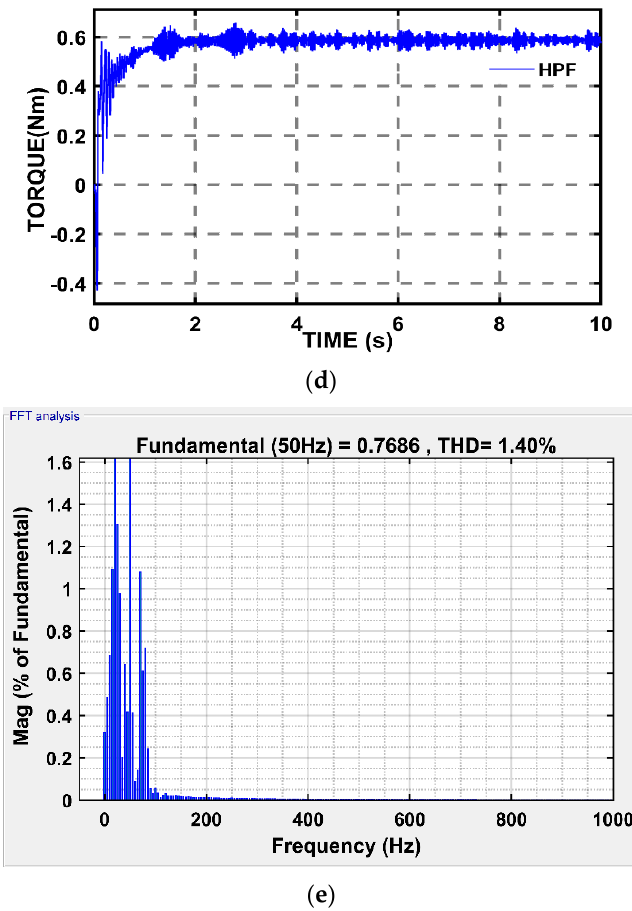
Figure 10. The performance of the drive using a hybrid power filter for case 1. ( a ) Source voltage. ( b ) Source current. ( c ) Speed. ( d ) Torque. ( e ) THD of source current.